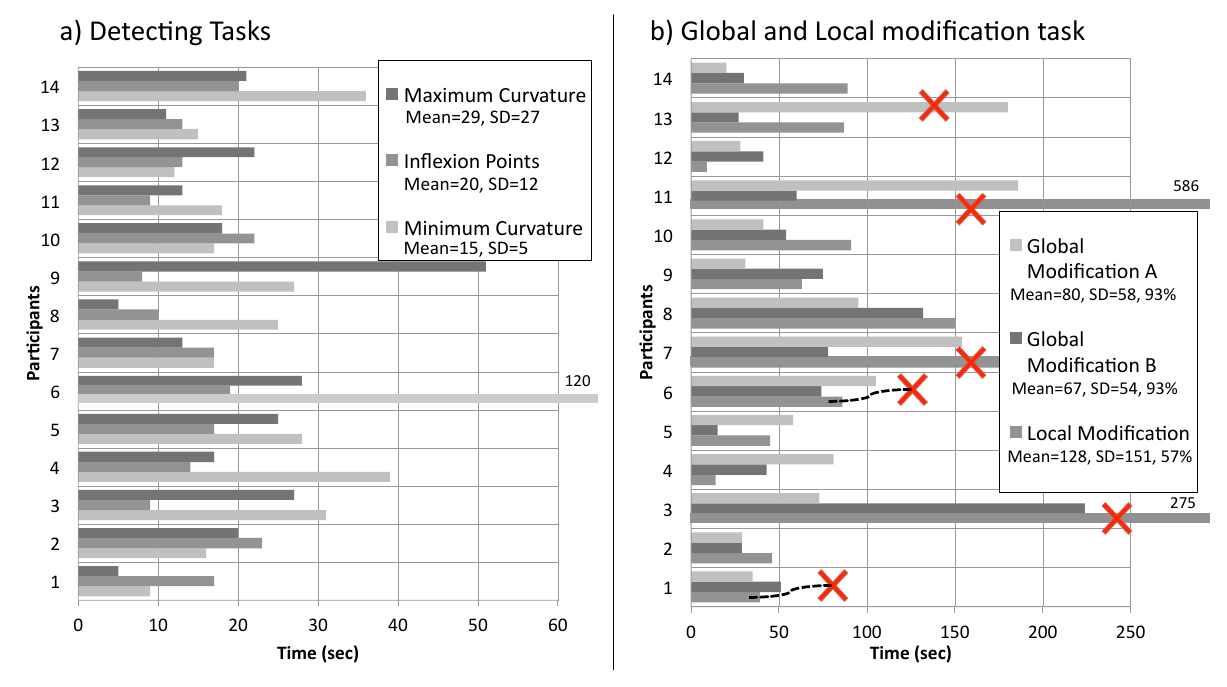
Figure 15. Tasks